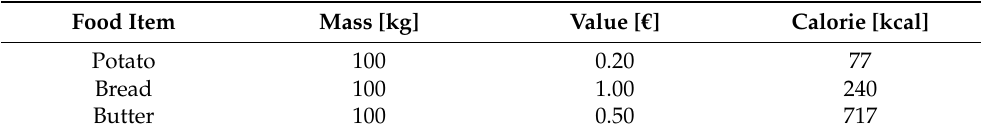
Table 1. Comparison of different aggregation methods. [26].